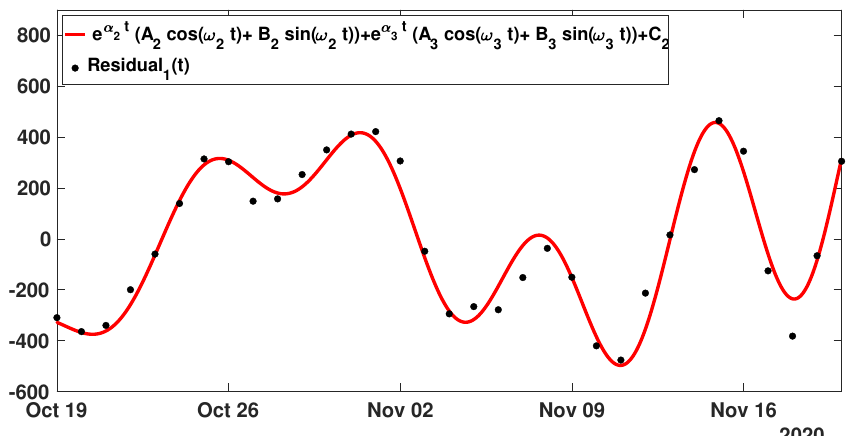
Figure 14. In this figure, we plot the cumulative number of reported cases data between 19 October and 19 November 2020 (black dots). we plot the best fit of the model (30) to the cumulative data (red